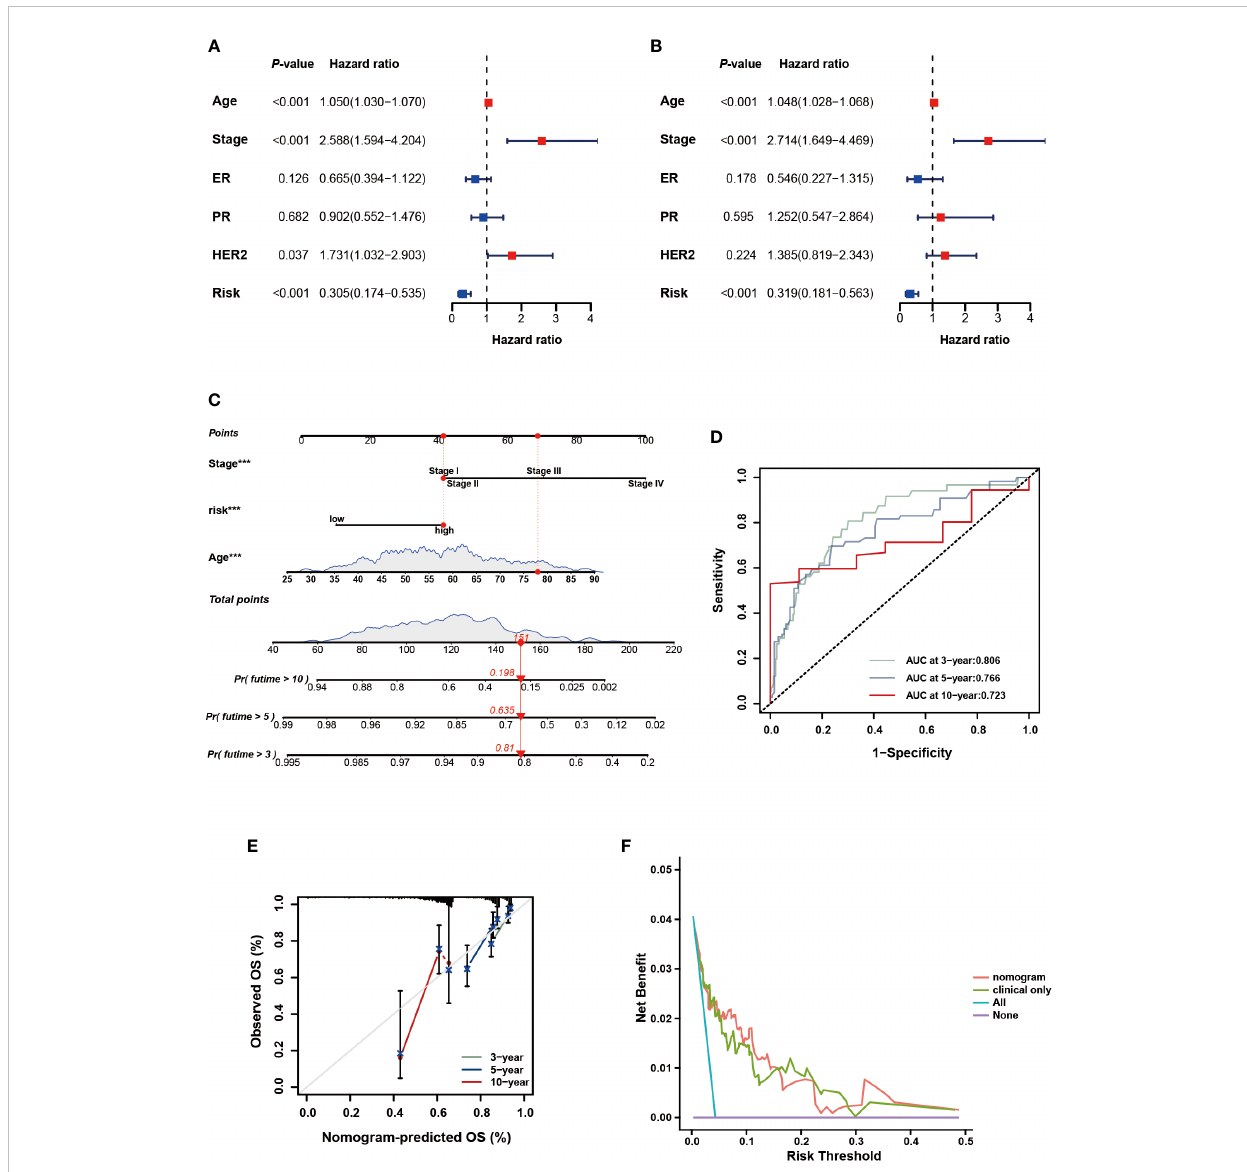
FIGURE 7 Development and assessment of the nomogram. (A) Univariate regression. (B) Multivariate regression of the clinicopathological indicators and gene signature. (C) A comprehensive nomogram for predicting BC patients ’ survival probability. (D) The time-dependent ROC curves of the nomogram. (E) Calibration curves of the nomogram at 3-, 5-, and 10-year intervals. (F) DCA curves of the clinicopathological indicators and this